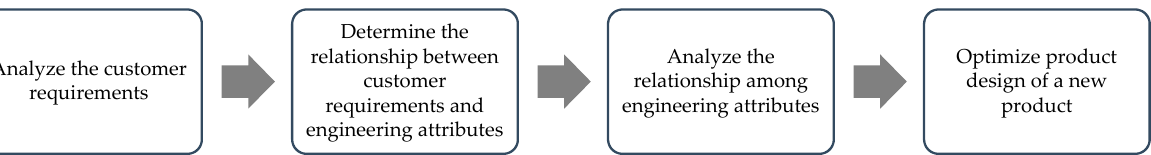
Figure 9. The guidelines recommended for creating a new product design.